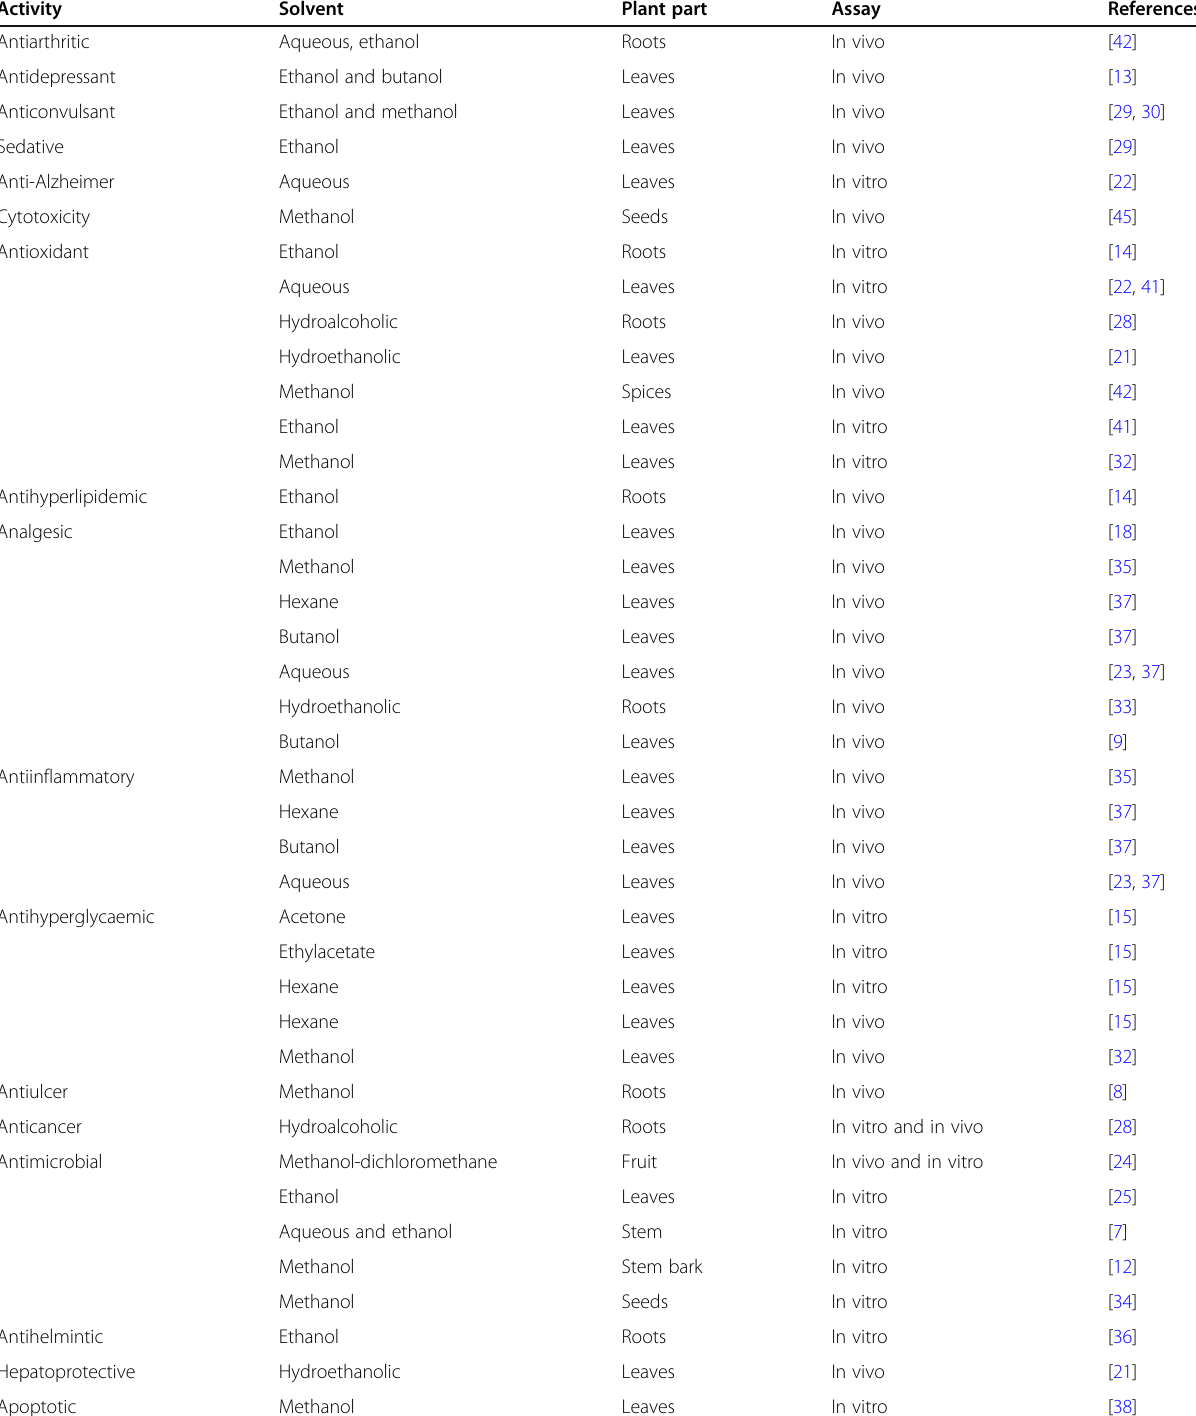
Table 4 Reported pharmacological activities of Olax subscorpioidea Activity Solvent Plant